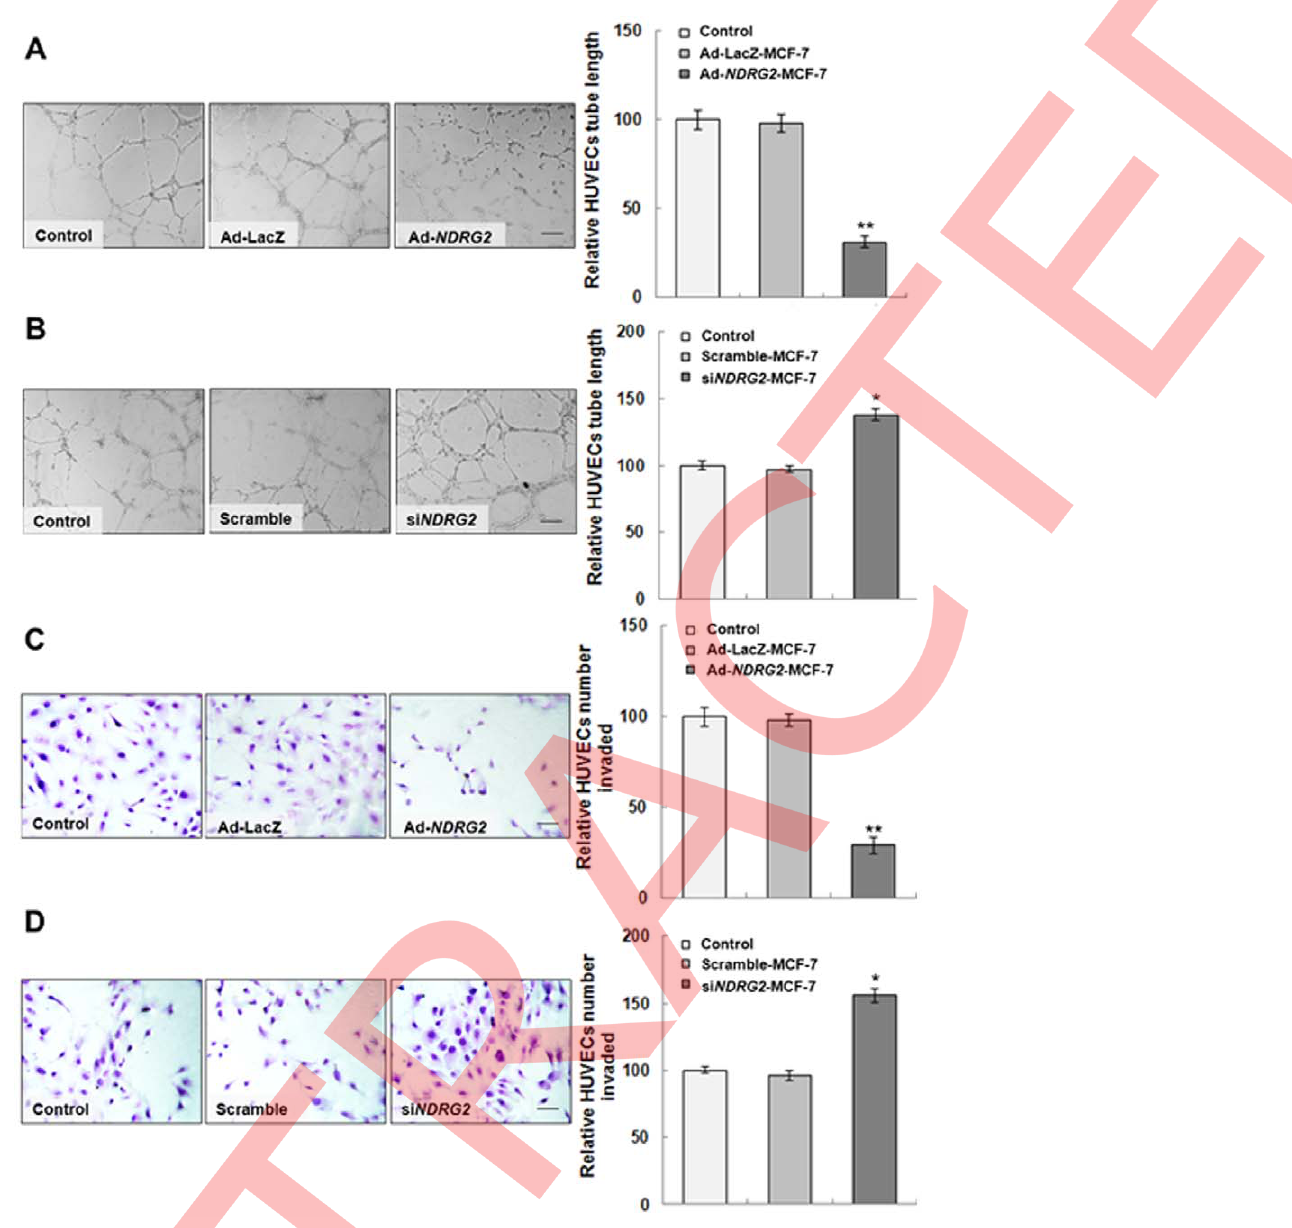
Figure 3. Effect of MCF-7 preconditioned media on HUVEC tube formation and invasion. (A and B) The tube formation assay was performed as described in Material and Methods. HUVECs were plated on Matrigel and incubated under hypoxia for 6 h. Tube lengths were measured with Image-Pro Plus software; the histograms represent the quantification of the tube length of HUVECs. (C and D) The invasion assay was performed as described in Material and Methods. After 4 h under hypoxia, the amount of invaded cells was calculated in five random high-power fields (400 6 ), and the number from the control group was used as a control. The histogram represents the quantification of cells that invaded. The data are the mean 6 standard deviation (SD) for three independent experiments. Statistical significance was assessed using one-way ANOVA and Student’s t -test. * or ** indicates P , 0.05 or P , 0.01, respectively, when compared with the control. The Ad-NDRG2 panel of Figure 3A is excluded from this article's CC-BY license. See the accompanying retraction notice for more